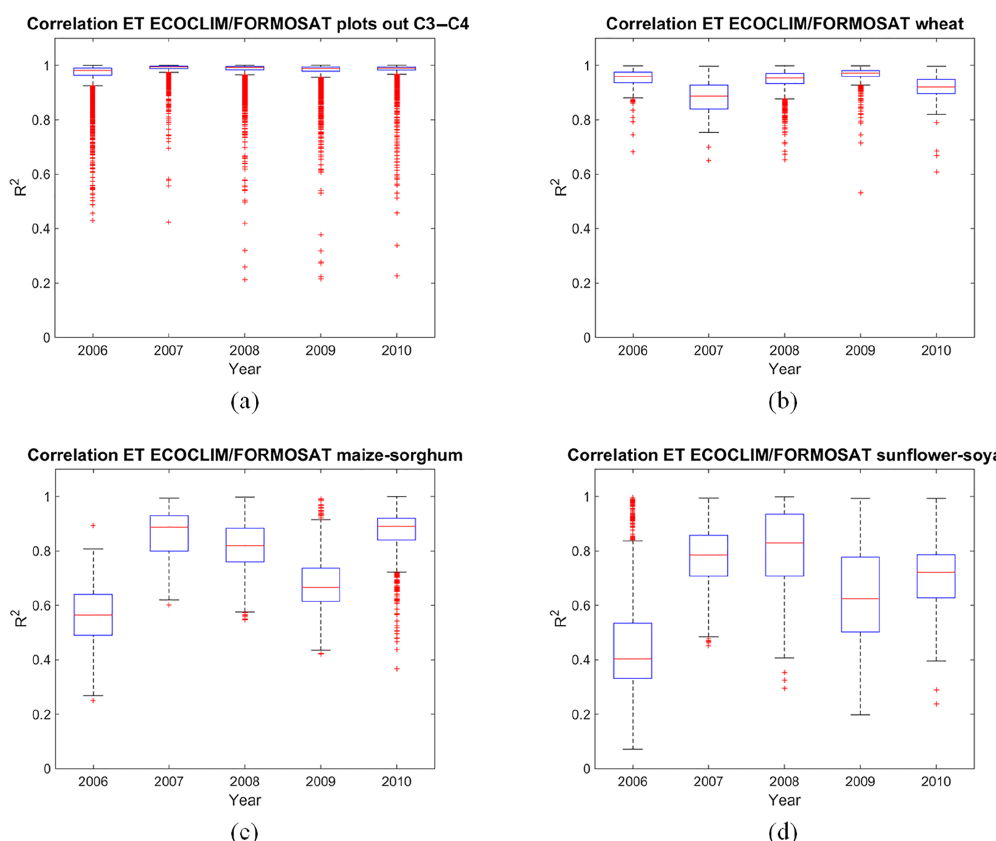
Figure 7. Correlations between the evapotranspiration time series of the two experiments on (a) uncultivated plots, (b) wheat crops, (c) C 4 crops (maize and sorghum), and (d) sunflower and soy crops. The box plots show the medians in red. Edges of each box represent quartiles whereas whiskers represent extreme values not considered as outliers (red dots are outliers). Table 5. Differences between FORMOSAT and ECOCLIMAP experiments on annual runoff in mmyr − 1 and the corresponding fraction of annual precipitation in percent